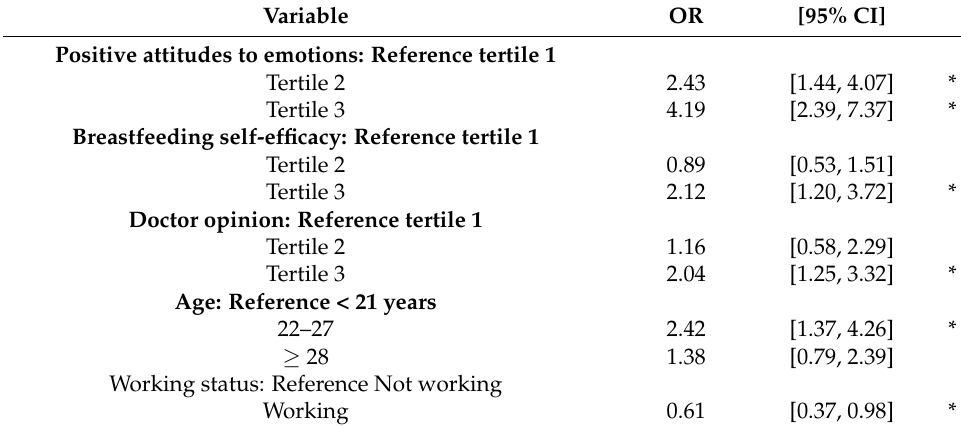
Table 5. Logistic multivariate model for breastfeeding intention a